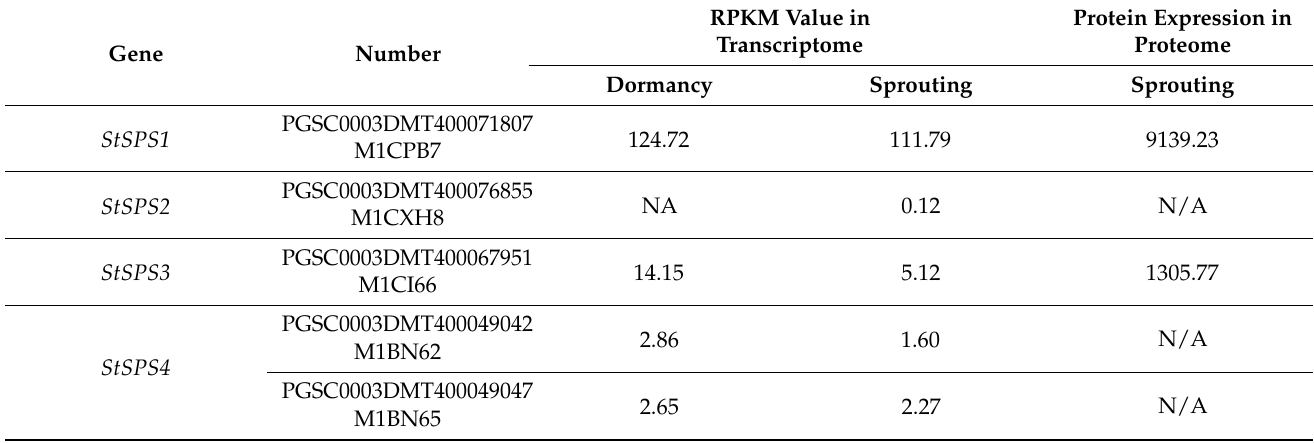
Table 5. Expression of StSPS in transcriptome and proteome research on tuber dormancy and sprouting. Number stands for the ID in PGSC and EBI databases. RPKM represents reads per kilobase million bases in transcriptome research.